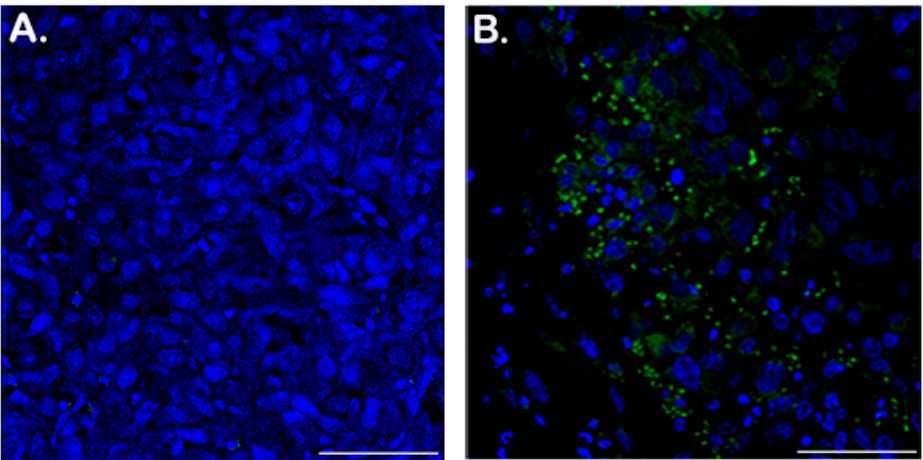
Figure 3. Immunohistochemistry of PC3-LgBiT tumor sections show HiBiT-reporter virus persistence within tumor xenografts 43 days post infection. Virus infected cells assessed via hexon detection in tumor xenografts. Frozen sections of tumors injected with PBS ( A ) or HiBiT-reporter virus ( B ) were stained by immunohistochemistry for adenovirus detection with an anti-hexon antibody and an Alexa Fluor 488-labeled secondary antibody; the sections were counterstained with Hoechst in TBS. ( A ) Representative control section from a tumor injected with PBS. ( B ) A representative section from virus-infected tumors at 43 days post infection. Size of the scale bar is 100 µm.